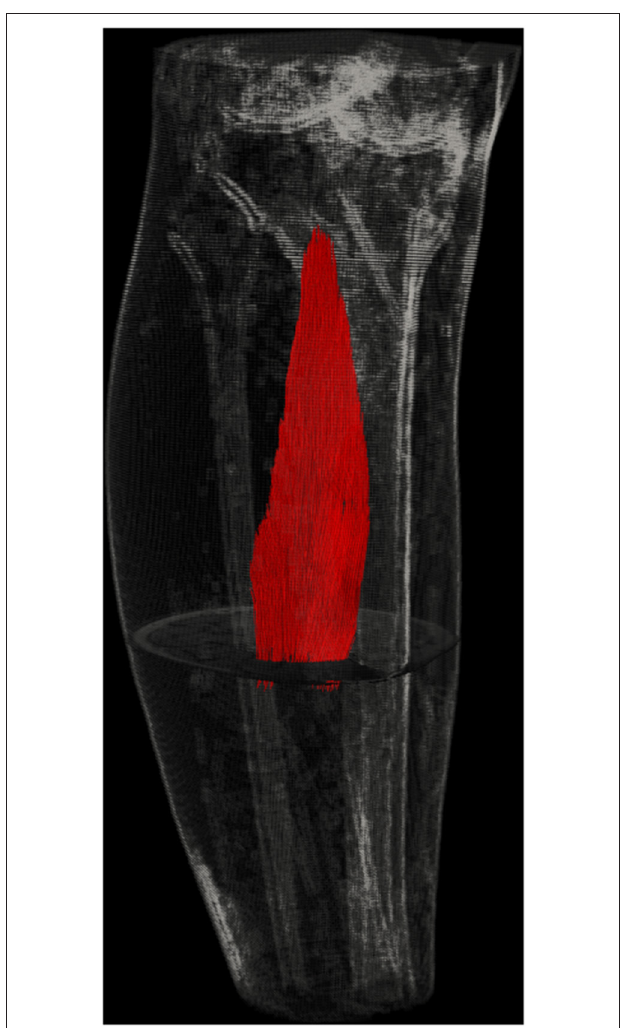
FIGURE 1 | Visualization of human muscle using MRI and DTI. Utilization of advanced imaging techniques offers major potential for analysis of structure as well as local muscle length and shape changes for human muscles in vivo